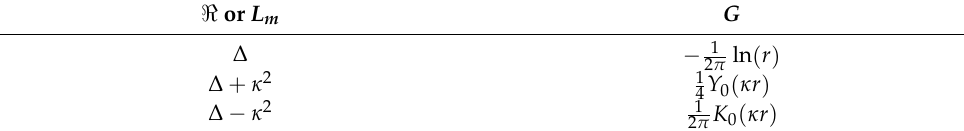
Table 1. Fundamental solutions of different differential operators in two-dimensional cases [31]. ℜ or